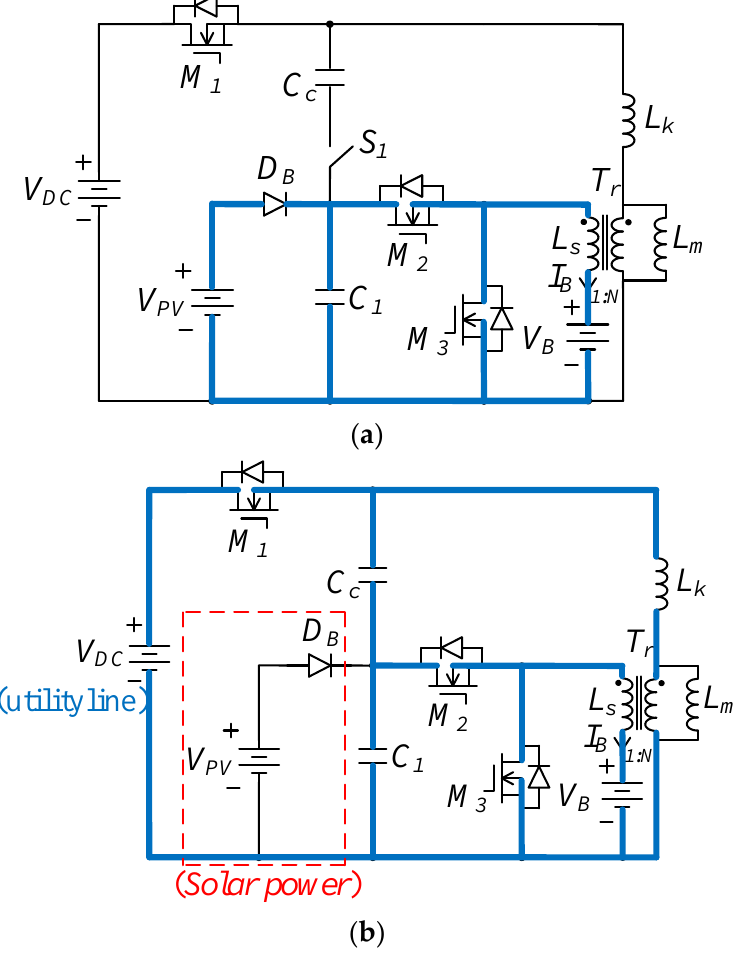
Figure 6. Equivalent circuit of the proposed hybrid converter in ( a ) buck converter mode for PV array source and ( b ) flyback converter mode for utility line source.